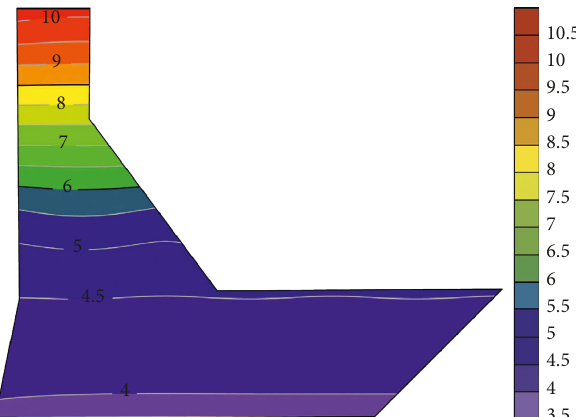
Figure 9: Distribution of the measured hydraulic displacement of the selected dam body section.